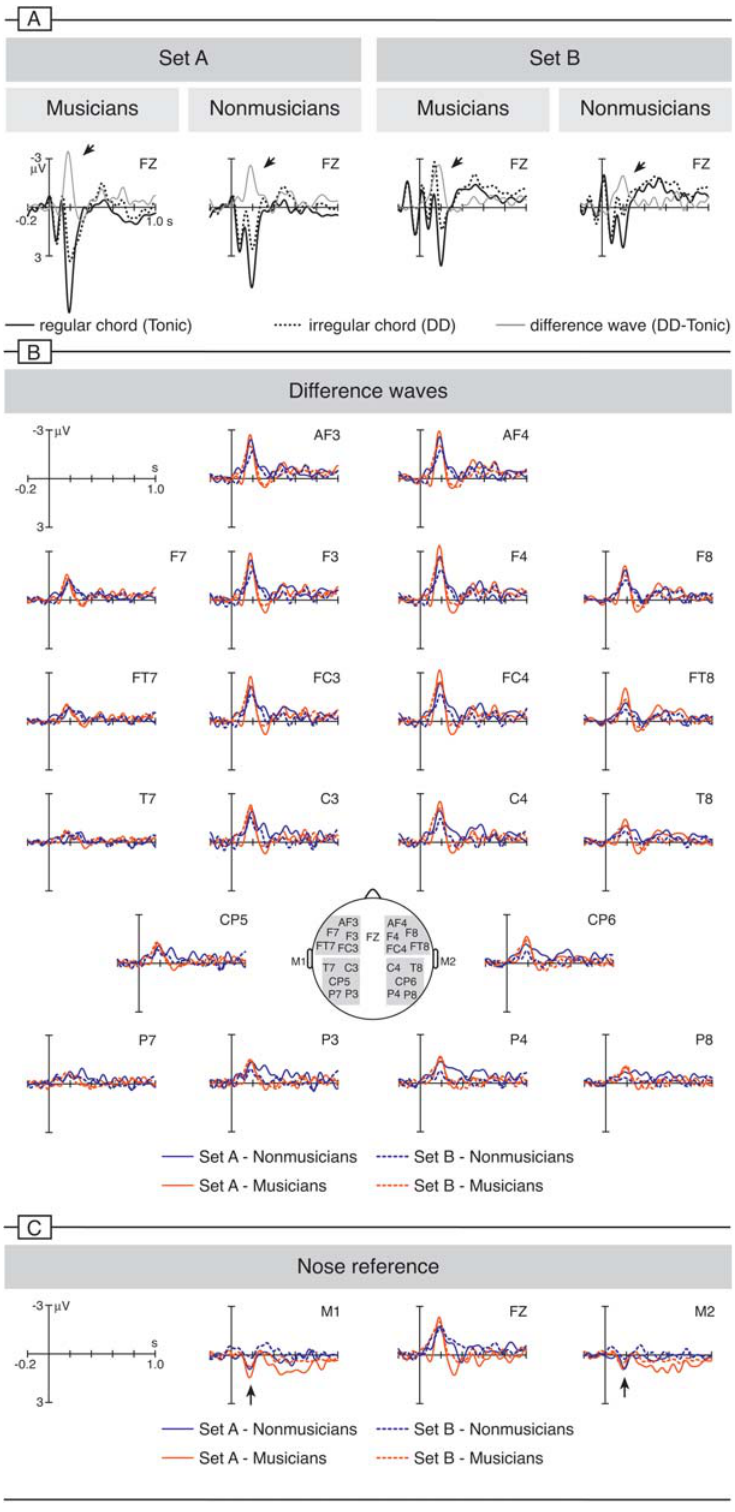
Figure 3. Grand-average ERP waveforms. A : ERPs elicited by the final chords at a frontal electrode (Fz, referenced to the algebraic mean of both mastoid electrodes). The thick solid line indicates potentials elicited by regular (tonic) chords, the dotted line responses to irregular chords (double dominants). The thin solid line represents the difference wave (regular subtracted from irregular chords). DDs elicited in both sets (A and B), and in both groups (musicians and nonmusicians) an early right anterior negativity (ERAN, see arrows). As can best be seen in the difference waves of B (regular subtracted from irregular chords, referenced to both mastoid electrodes), the ERAN was larger in Set A (solid lines) than in Set B (dashed lines), and larger in musicians (red lines) than in nonmusicians (blue lines). The inset depicts head positions of the electrodes shown in A and B, regions of interest used for statistical analyses are shaded in grey. C : When referenced to the nose electrode, the ERAN inverted polarity at mastoid leads (M1, M2, the polarity inversion is indicated by the arrows).